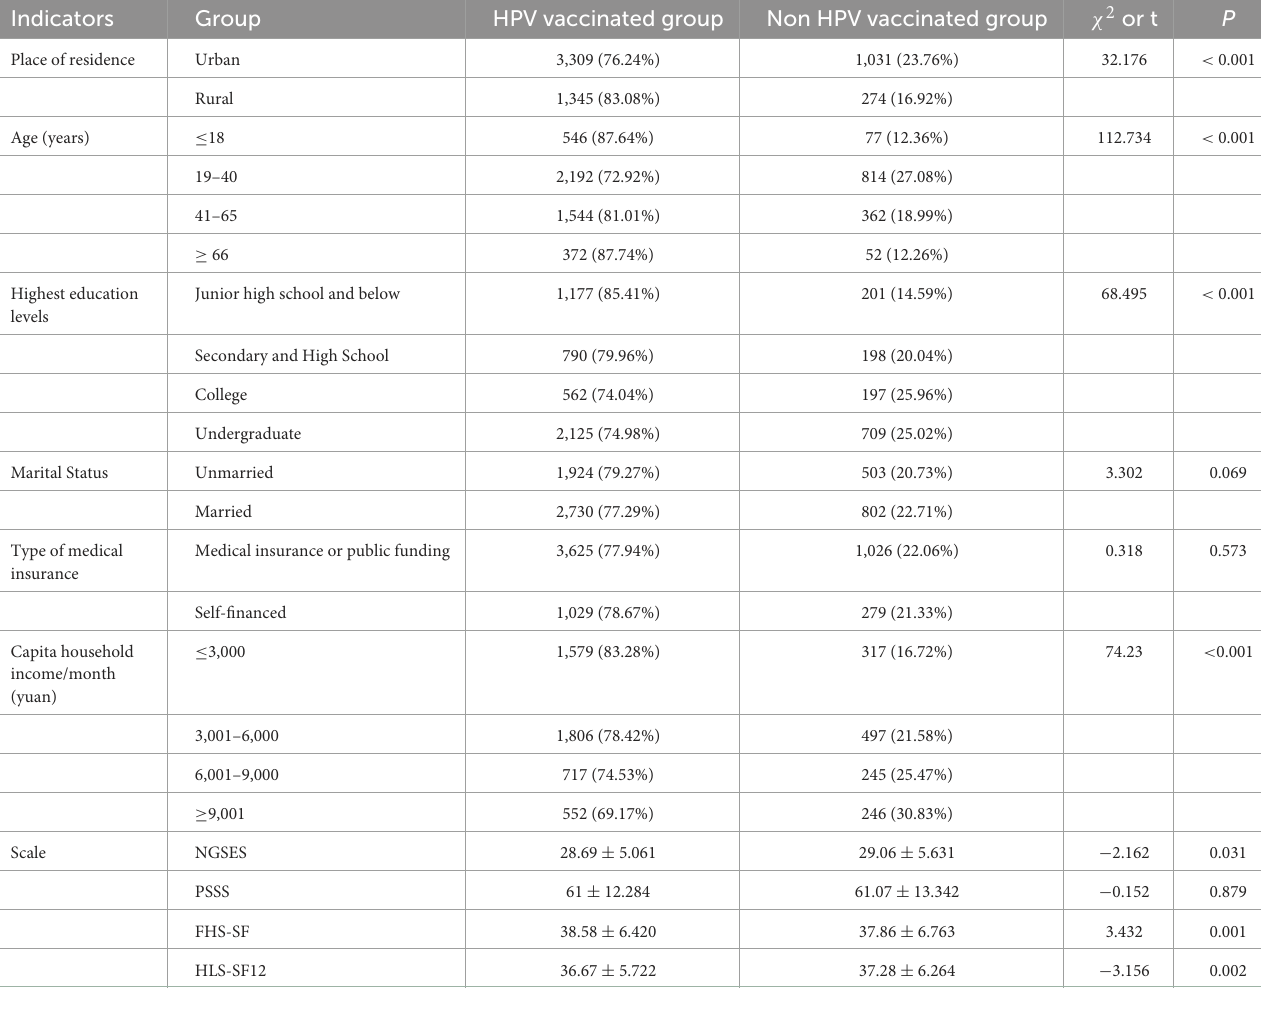
TABLE 1 Comparison of differences between HPV vaccinated and unvaccinated groups.